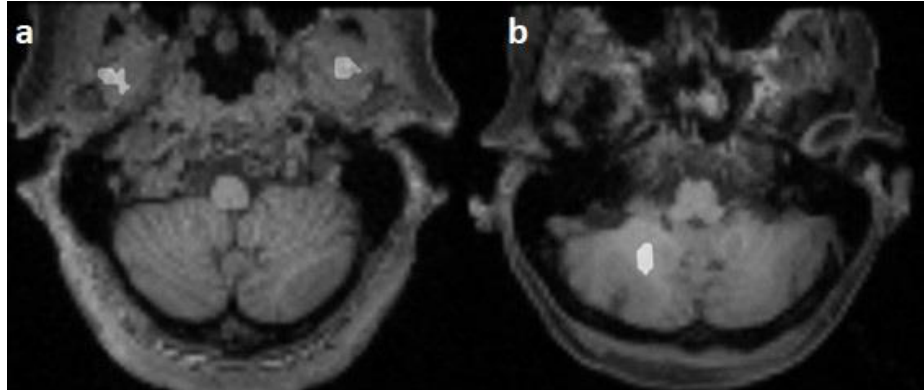
Figure 4. Falsely segmented areas (white) on horizontal T1-weighted images: mm. pterygoidei ( a ) and cerebellum ( b ).